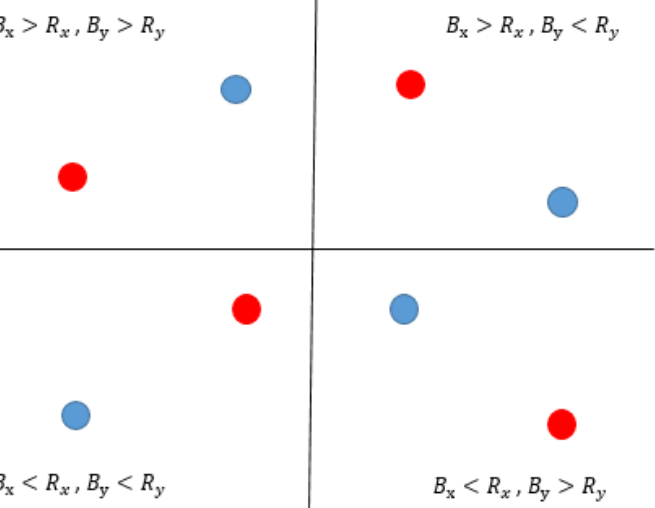
Figure 5. Finger rotation keypoint training. ( a ) The MSE loss graph of the heat map regression. ( b ) The MSE loss graph of the image coordinates converted from the heat map. ( c ) The accuracy of the test and training data.